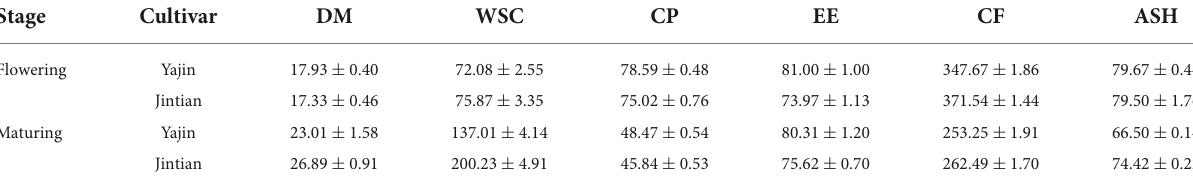
TABLE 2 The chemical composition (g kg − 1 DM) of sweet sorghum straw at flowering and maturing stages. Stage